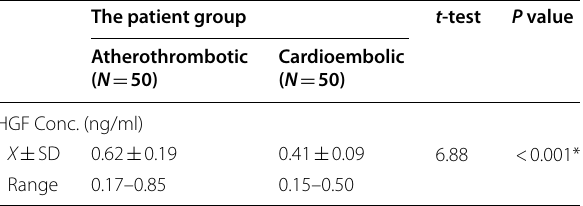
Table 8 HGF concentration in atherothrombotic and